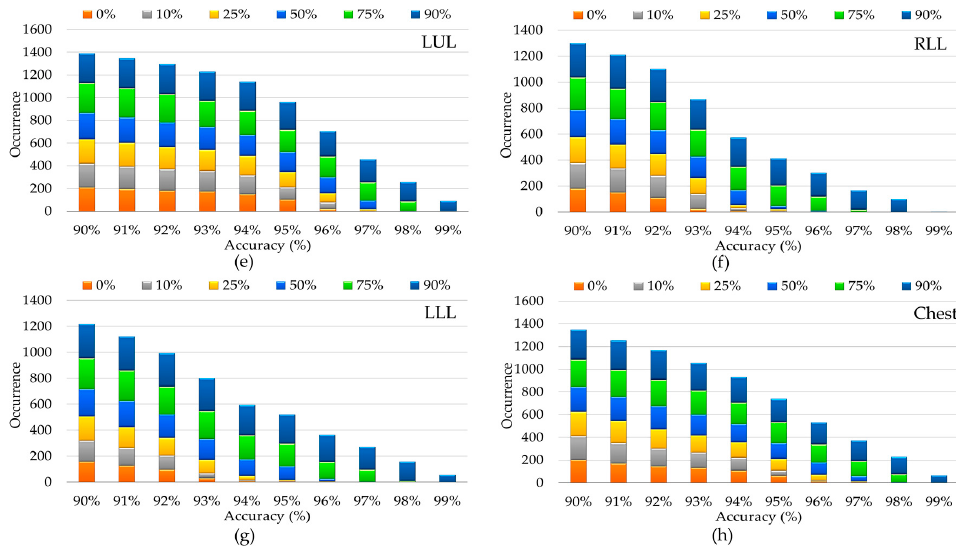
Figure 10. Analysis of number of classifiers, which provide good results (90%–99%) by taking different overlap sizes into account for different positions.